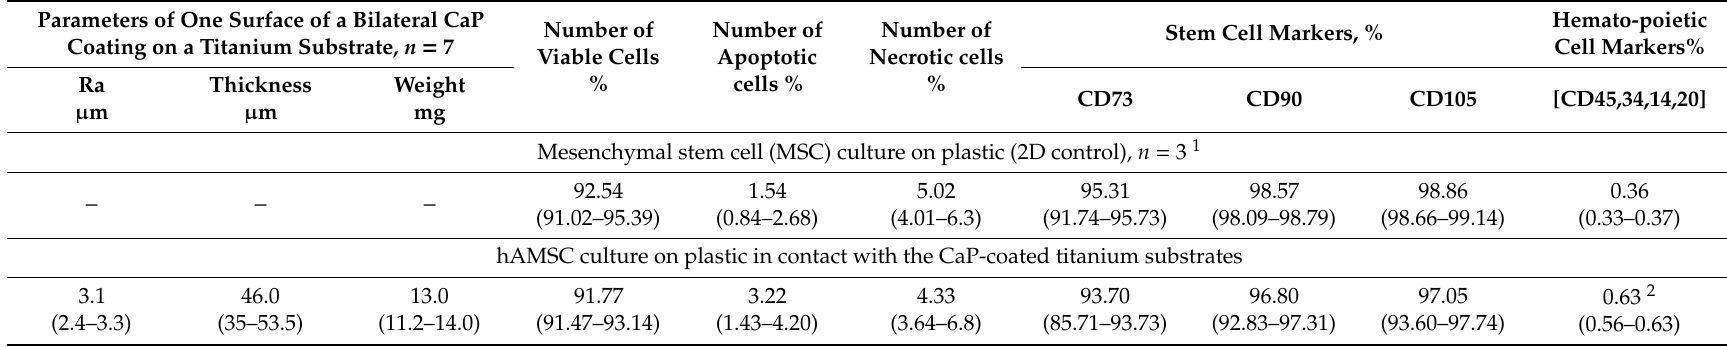
Table 1. Viability and immunophenotype of human adipose-derived MSCs (hAMSCs) collected from plastic after 14 days of coculture with the microarc CaP-coated titanium substrates, Me